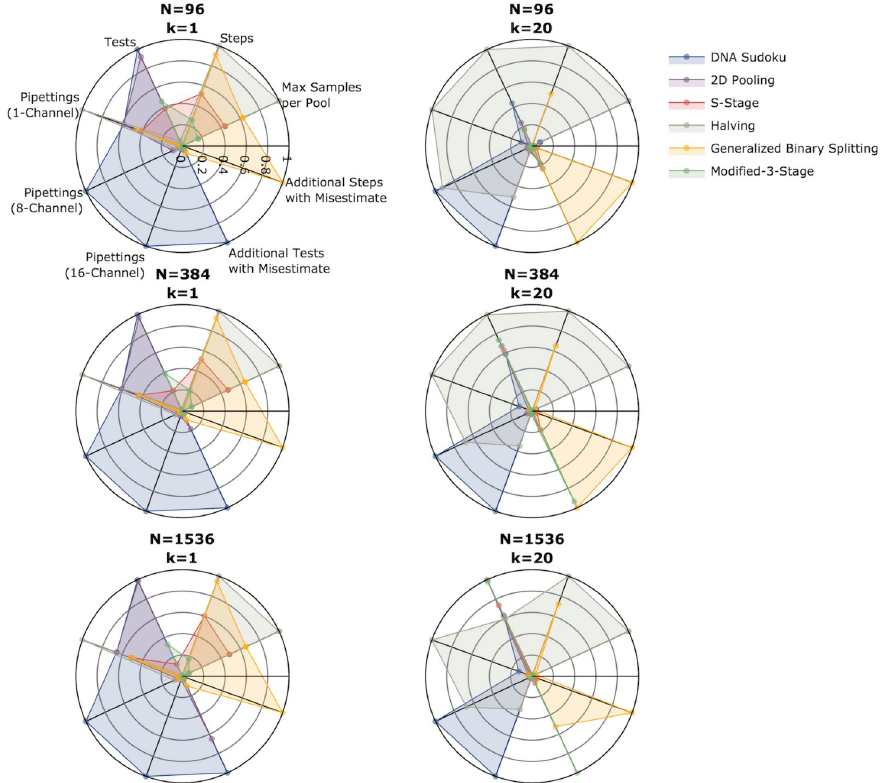
Fig 6. Comparison of five pooling methods. The radar charts show the average number of tests, number of steps, maximum number of samples per pool, number of pipettings (for 1-, 8- and 16-channel pipettes), and the number of additional tests and steps required when the number of positive samples is overestimated ( k = 1, ^ k ¼ 20 ) or underestimated ( k = 20, ^ k ¼ 1 ). The left column shows results from simulations with one positive sample and the right column shows simulations with 20 positive samples. The rows are different sample sizes from top to bottom: 96, 384, and 1,596. In each plot the values for each feature have been Min-Max normalized. In each category, methods with points at the center performed the best while methods with points near the edge performed the worst.